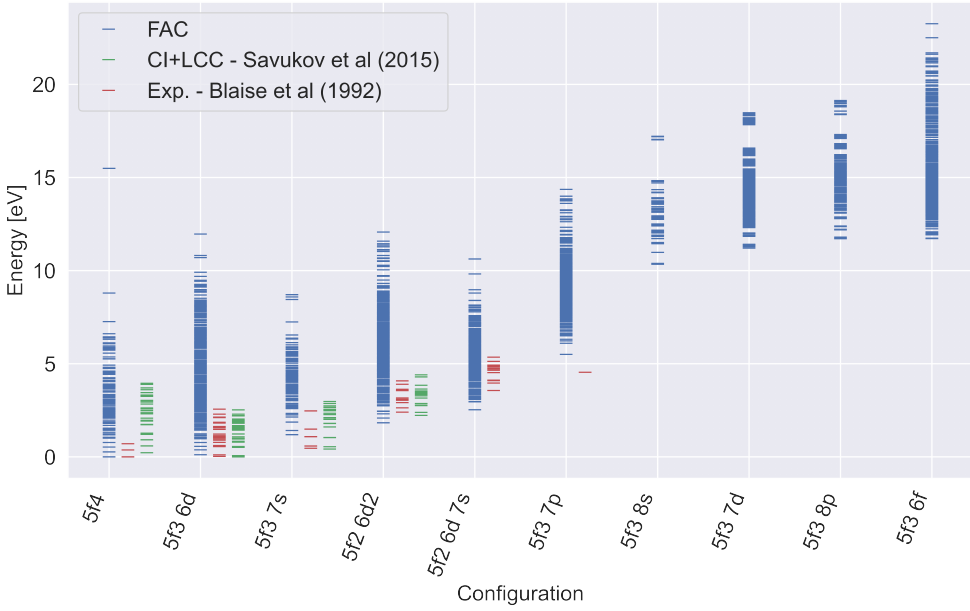
Figure 2. Energy levels for configurations of U III calculated with FAC. The excitation energies are compared with the experimental results from Blaise et al. [23] and the CI+LCC calculations from Savukov et al. [26].